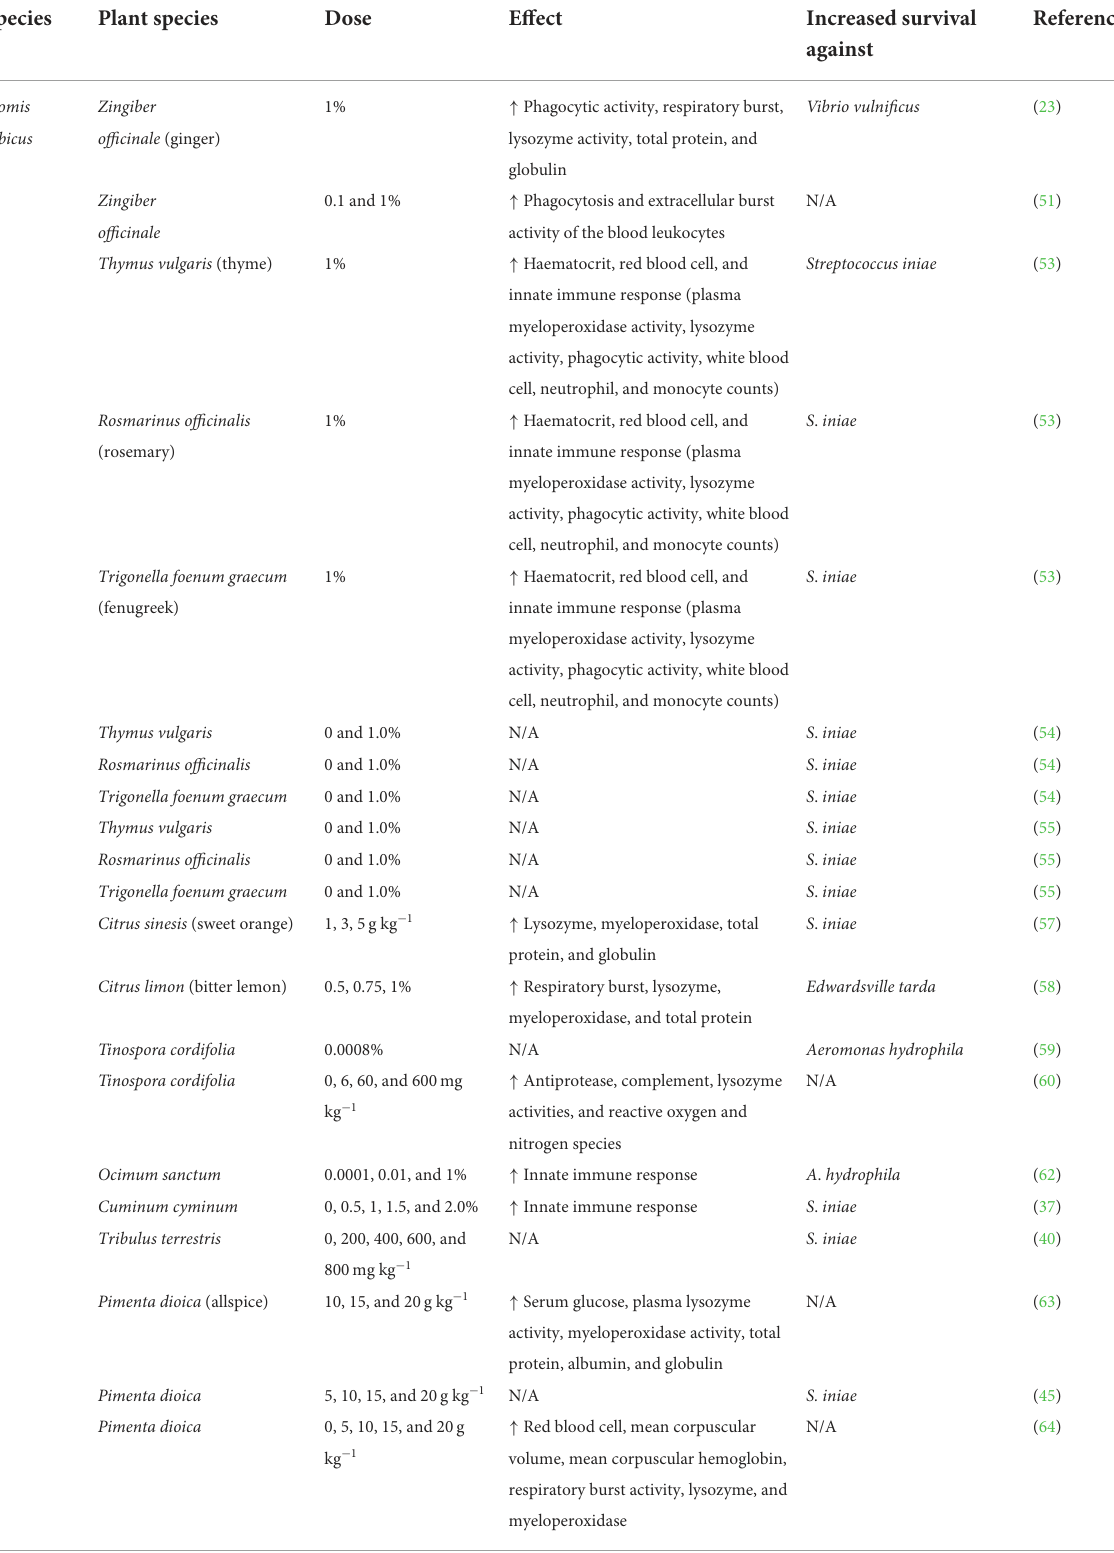
TABLE 2 Plants that have been shown to enhance immunity and disease resistance in Oreochromis mossambicus and Clarias gariepinus . Fish